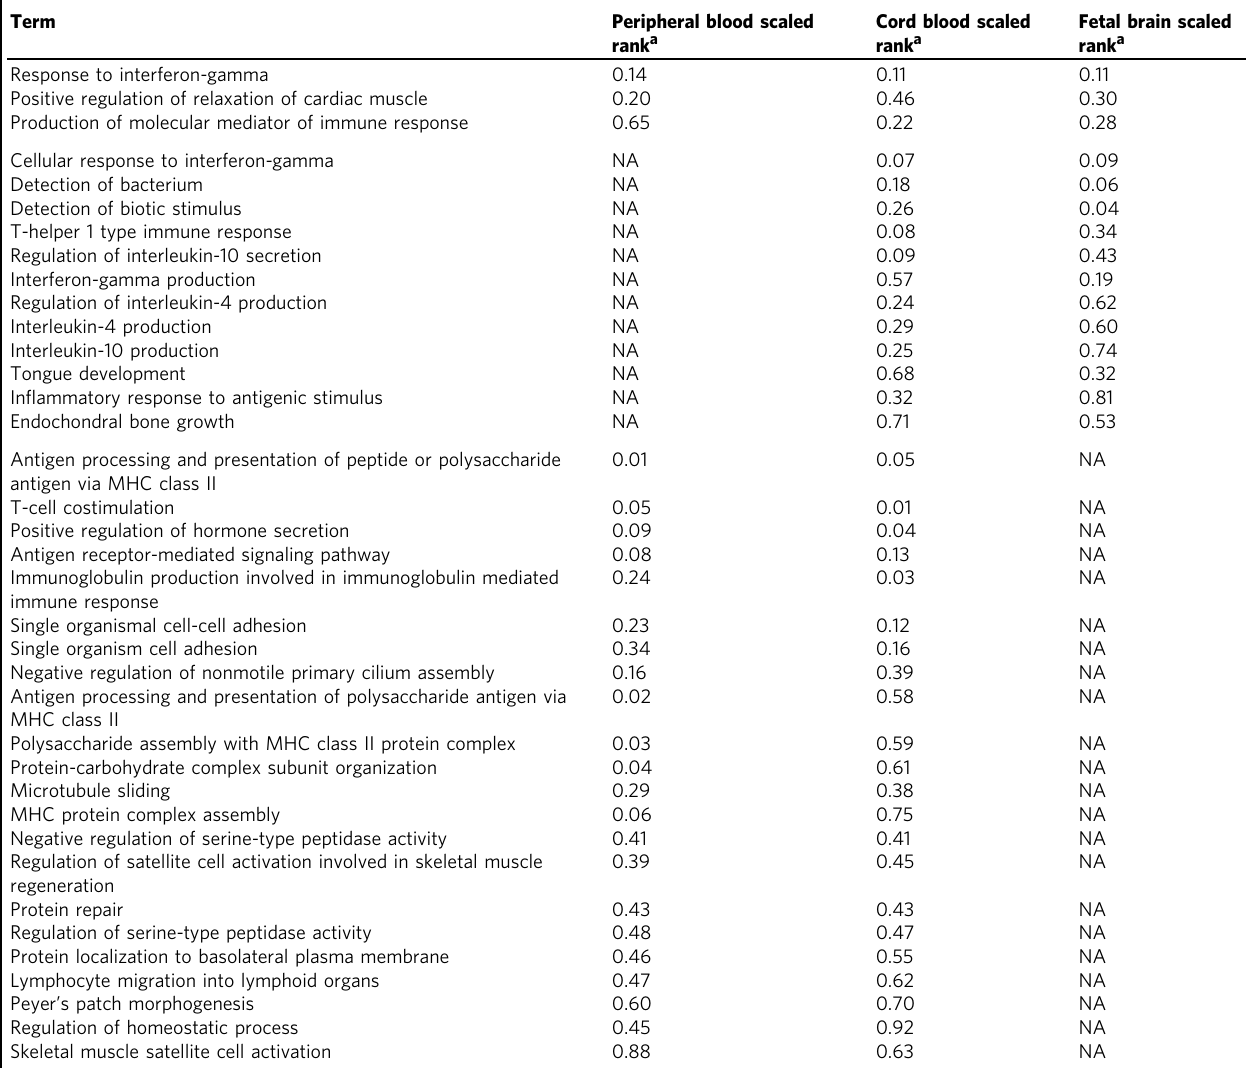
Table 3 Gene Ontology terms signi fi cantly enriched in multiple tissue types in comparison of ASD-related meQTL targets